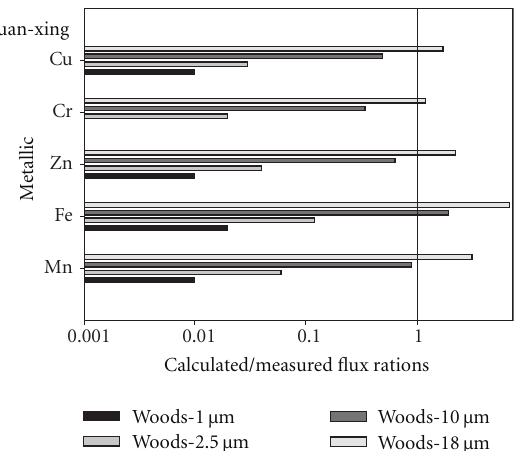
Figure 5: It displays the average calculated/measured flux ratios by using Woods models in the prediction of ambient air metallic elements dry deposition for various particle sizes (1 μ m, 2.5 μ m, 10 μ m, and 18 μ m) at Quan-xing sample